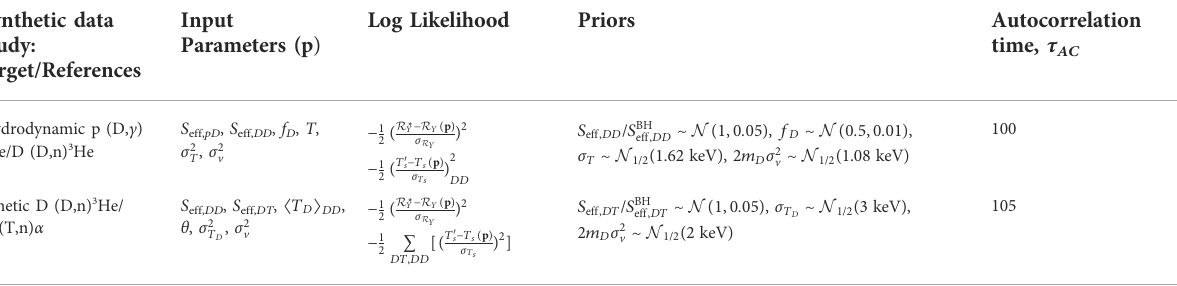
TABLE 1 A table summarising the Bayesian model and MCMC sampling statistics for the two synthetic data studies in this work.